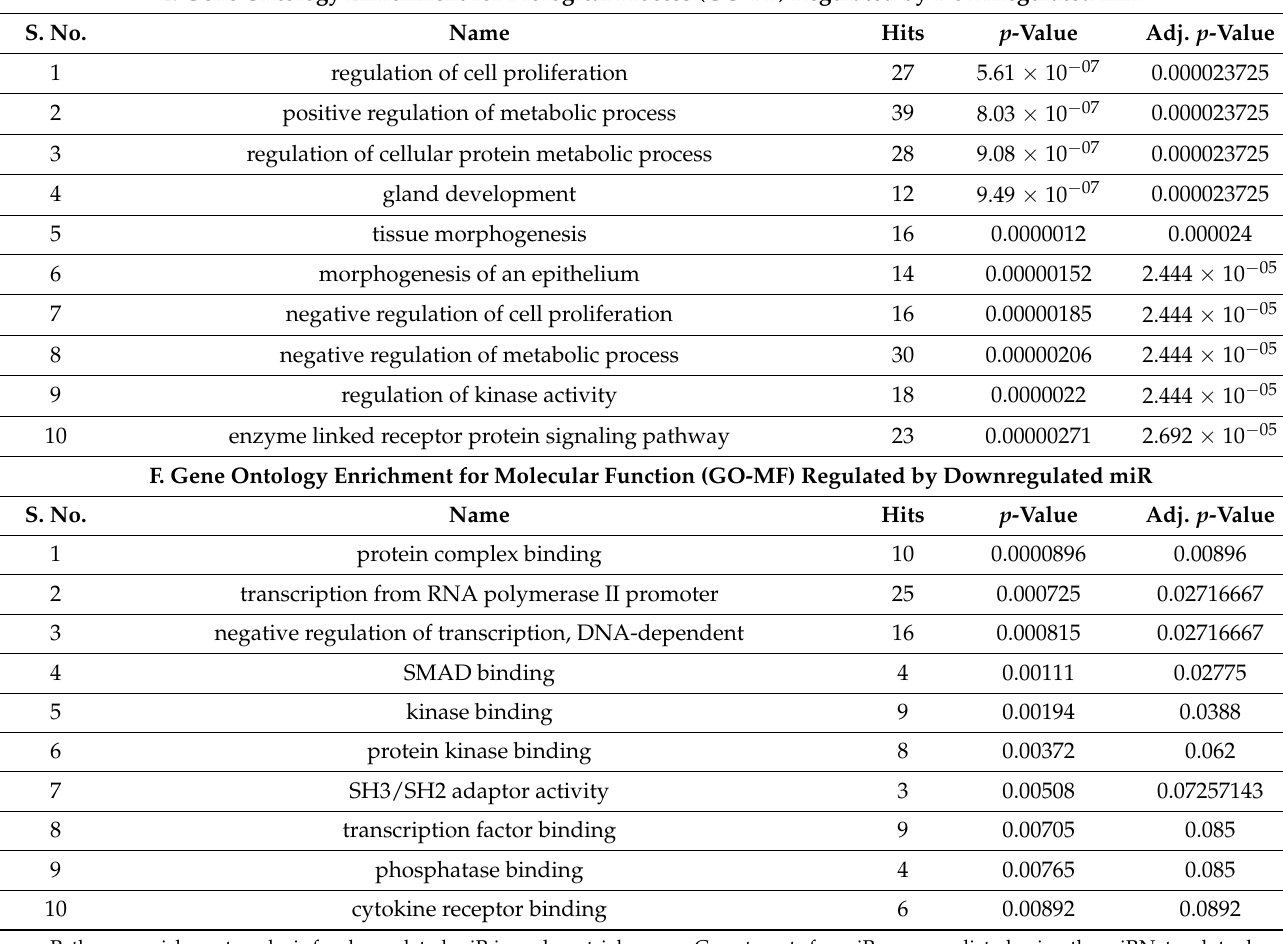
E. Gene Ontology Enrichment for Biological Process (GO-BP) Regulated by Downregulated